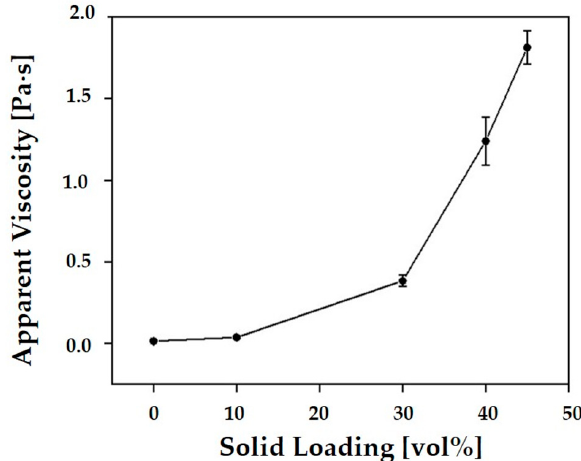
Figure 3. Apparent viscosity of the CaP slurries as a function of solid loading ( ϕ = 10 vol%, 30 vol%, 40 vol%, and 45 vol%).